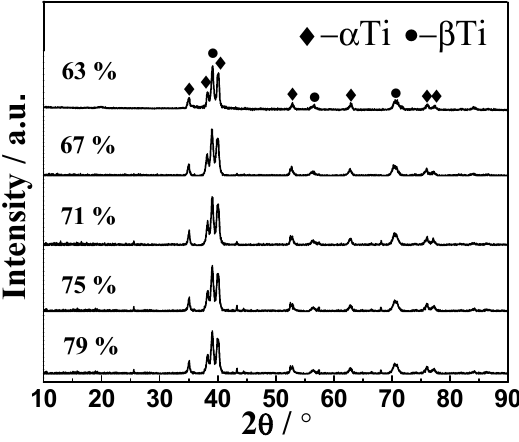
Figure 4. X-ray diffraction patterns of Ti-10Mo alloy with different content NH 4 HCO 3 added.